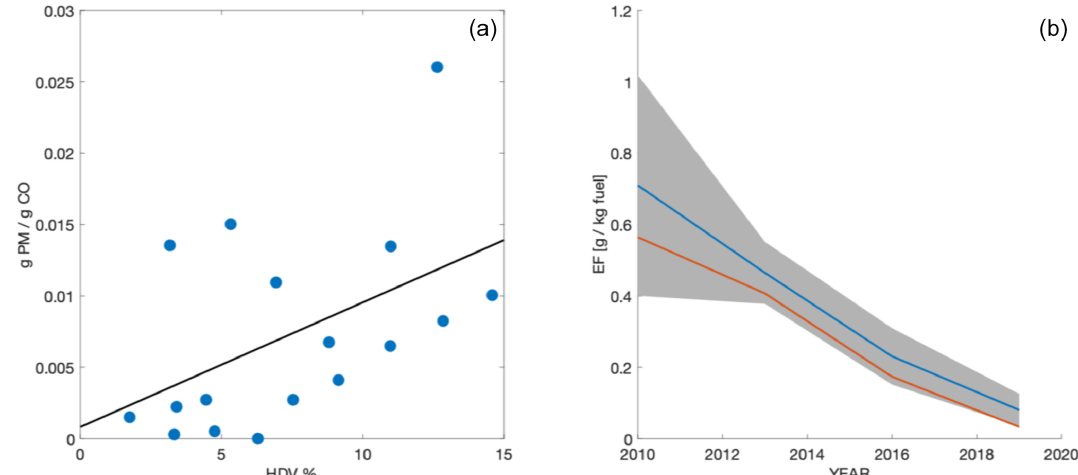
Figure 5. (a) Each point corresponds to the PM:CO enhancement ratio calculated via a linear fit between PM enhancement and CO enhancement at a particular near-highway site during the 2018–2020 time period for each bin of HDV (%). Laney College data are not included. The black line shows the linear fit corresponding to all points. (b) Trend in EF PM(HDV) for RWC and SR (as shown in Fig. 1). The blue line indicates values calculated for the setting EF PM(LDV) = 0, while the orange line indicates values calculated using EF PM(LDV) = 0 . 002gPMkg − 1 fuel. Gray patches indicate the estimated uncertainty in the error-weighted mean for the case where EF PM(LDV) =